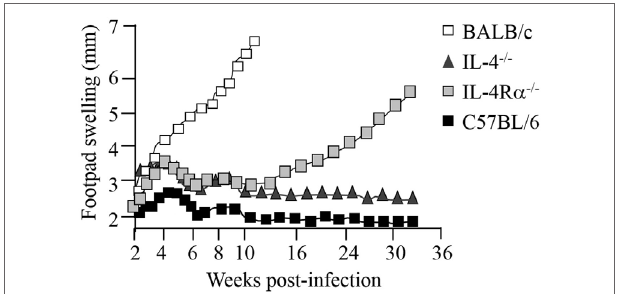
FiGURe 3 | Disease progression in Leishmania major -infected-IL-4 − / − and IL-4R α − / − mice. BALB/c mice deficient for interleukin-4 (IL-4) and interleukin-4 receptor alpha (IL-4R α ) were infected with L. major LV39 strain and footpad swelling monitored weekly as an indication of disease progression. Illustration prepared according to published reports (7,